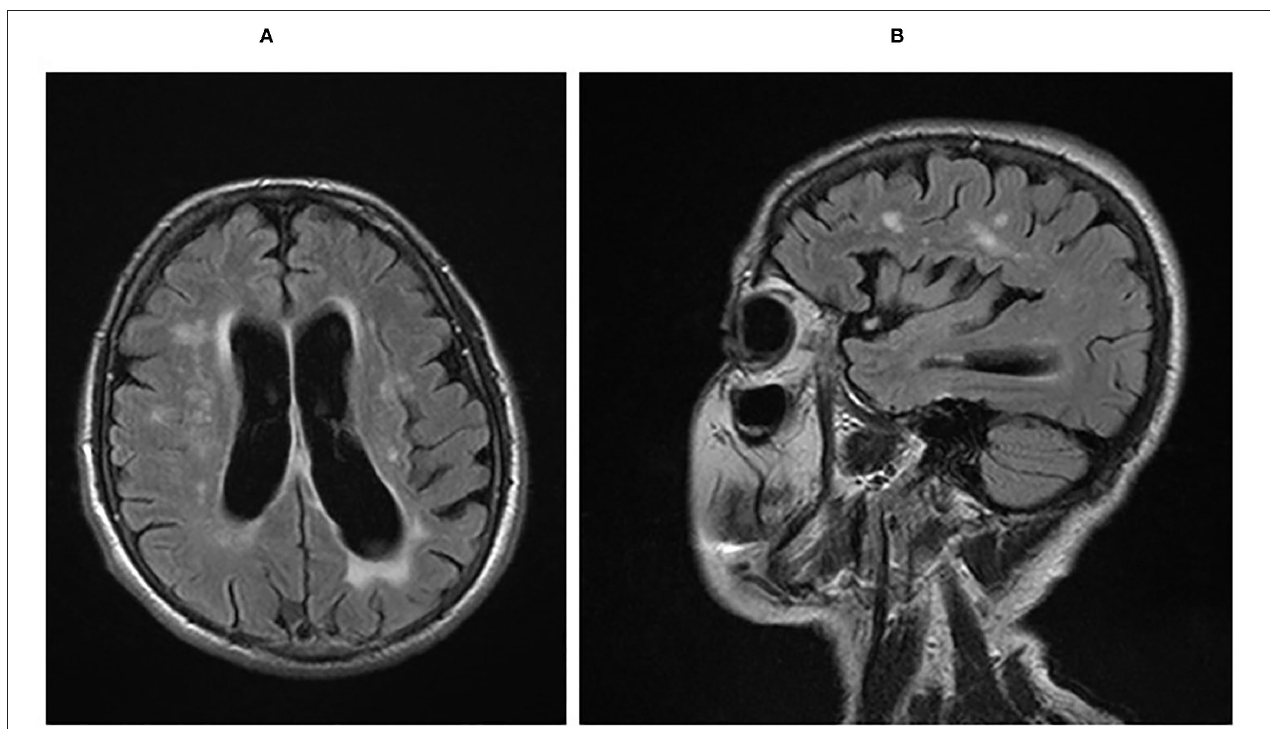
FIGURE 1 | (A) Sagittal FLAIR MRI sequence showing cerebral atrophy with a frontotemporal predilection and post-ischemic hyperinsities in the white matter. (B) Axial FLAIR MRI sequence showing asymmetry of frontotemporal atrophy with left-side predominance. FLAIR, fluid-attenuated inversion recovery; MRI, magnetic resonance